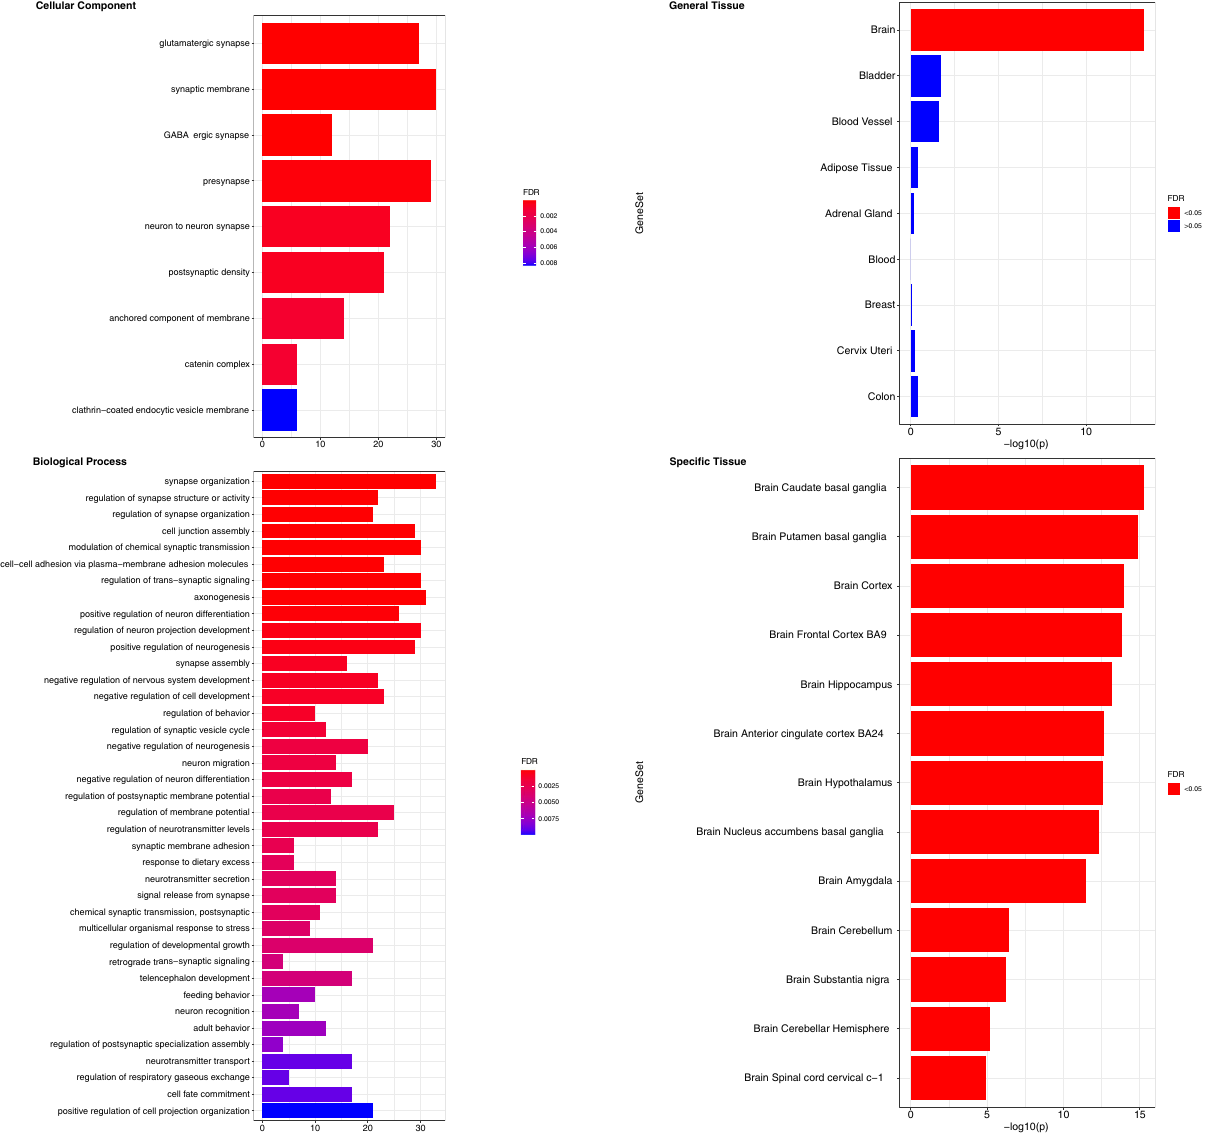
Fig. 6 Enrichment analysis of food-liking genes. Associated biological functions from Gene Ontology (GO) terms and tissue up-regulated genes using the prioritized genes from all loci with p < 5 ×10 − 8 are shown. The left panels show the summarized signi fi cant GO Terms (FDR < 0.05) for cellular component and biological processes, while the right ones report the tissue enrichment using the general tissues (upper panel) and the speci fi c ones (bottom